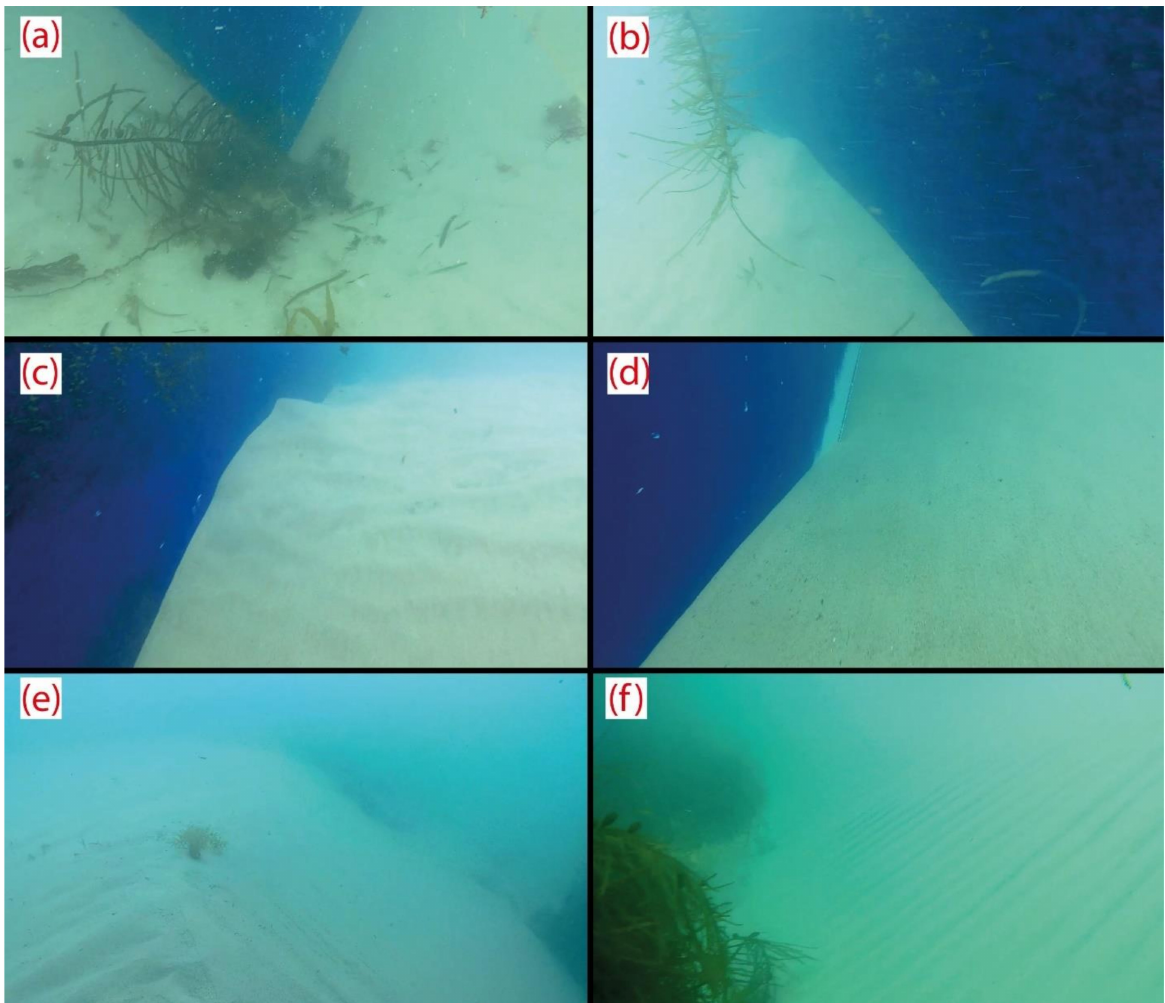
Figure 10. Photographs extracted from dive survey footage around the OWC WEC at Location 2 on 1 February 2021. ( a – f ) refer to photographic references given in Figure 9. ( a , b ) show a scour hole on the back outer corner of the Western pontoon from different angles, which does not appear to have undermined the pontoon. ( c ) Photograph from the perspective of the back outer corner of the Western pontoon, this photo shows a relatively elevated zone of sediment with sand wave peaks visible. ( d ) The location along the outer edge of the Western pontoon where the base becomes exposed. ( e ) A large mound of sediment is visible at the front of the OWC WEC, sloping steeply down towards the chamber door. ( f ) Photograph looking in a Northern direction along the outer edge of the East pontoon, a steep slope can be seen in that right of the photograph sloping upwards away from the